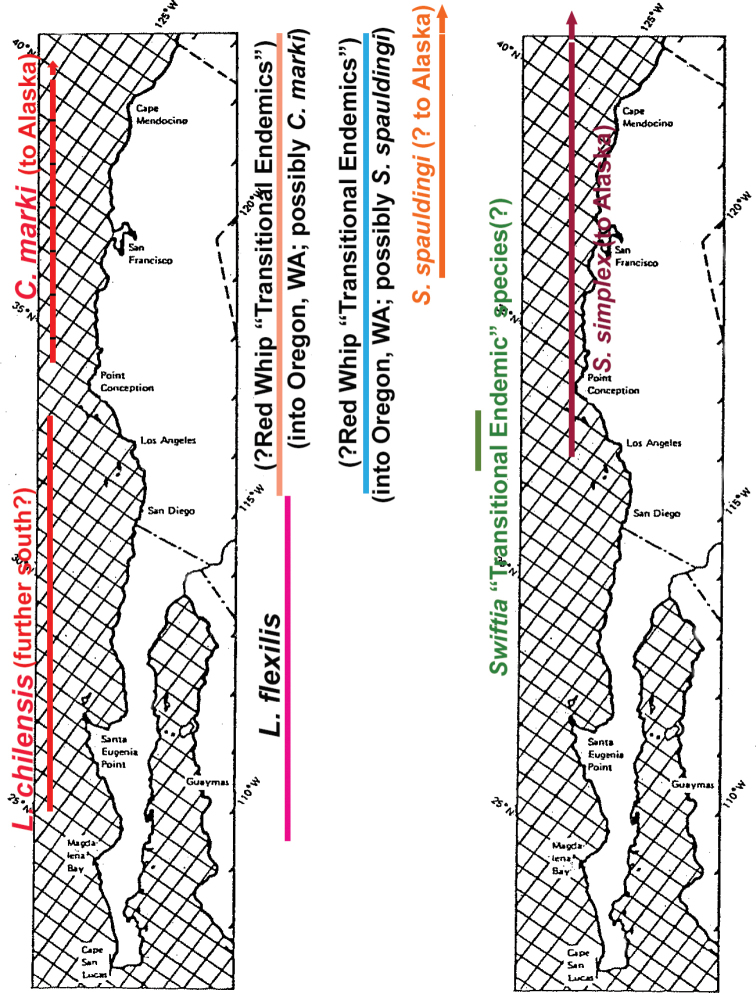
Distribution of gorgonian “red whip” forms. Includes species that are predominantly seen as a whip rather than a branched colony as well as several species that, while usually branched, do frequently display a slender, whip-like body type. Ranges determined from all material examined, with emphasis on specimens housed in SBMNH collection.